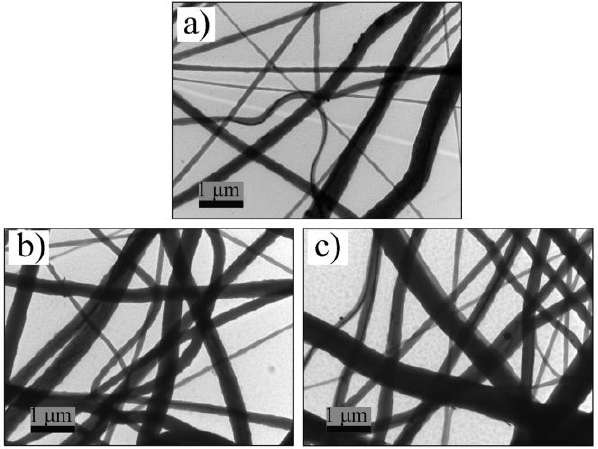
Figure 5. TEM micrographs of Ag NWs doped PVDF. 0.5% Ag NWs doped nanofiers ( a ).